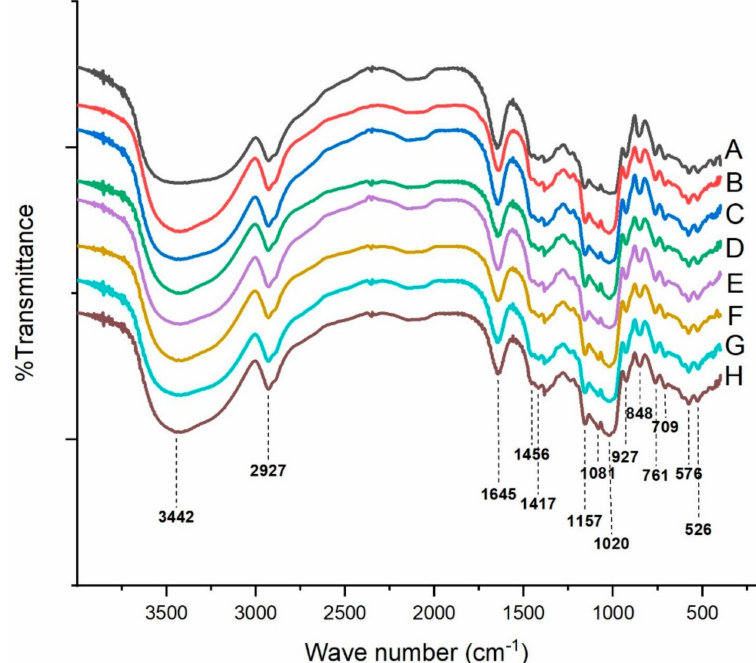
Figure 3. Fourier transform infrared analysis of the native starch and GSP-potato starch complexes.